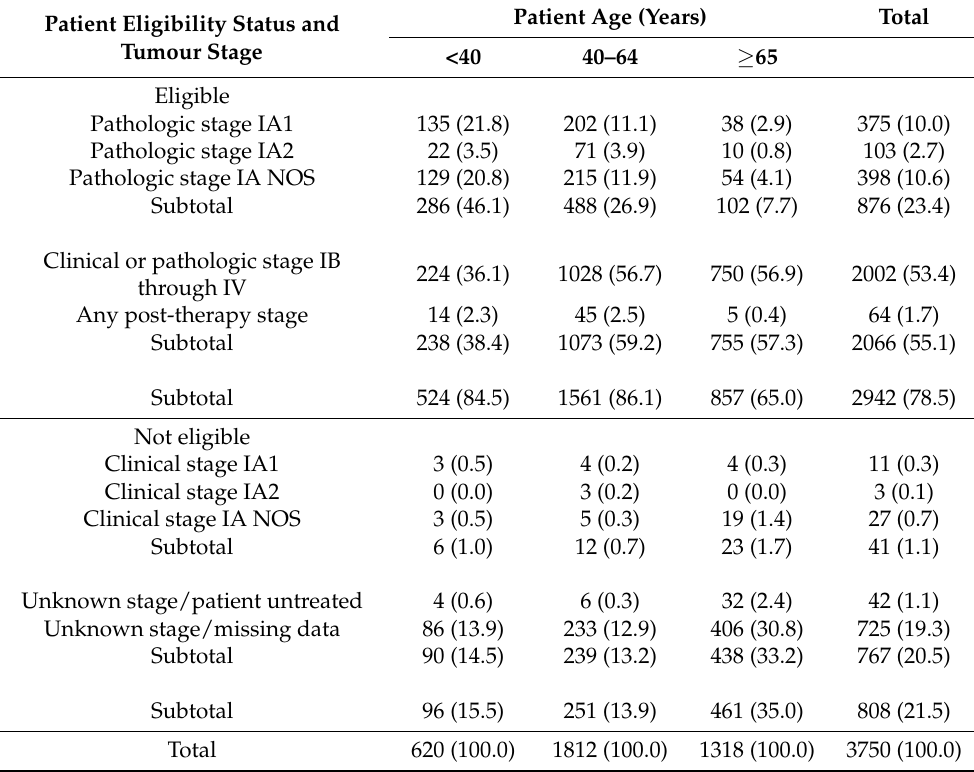
Table 1. Distribution of the original registry-based series of cervical carcinoma patients by eligibility status, tumour stage, and age group. Emilia-Romagna Region, Italy